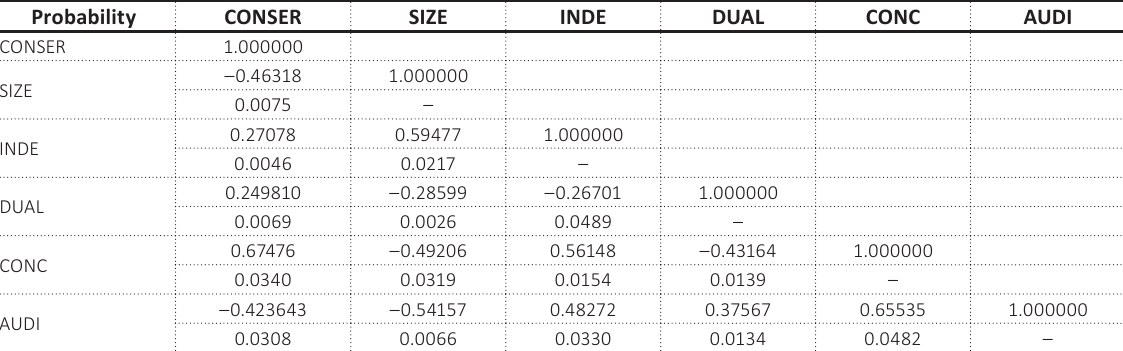
Table 2. Correlation